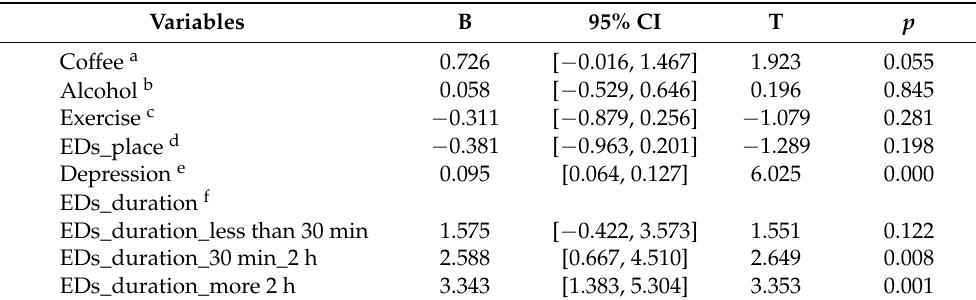
Table 4. Multiple linear regression analysis for sleep quality with related